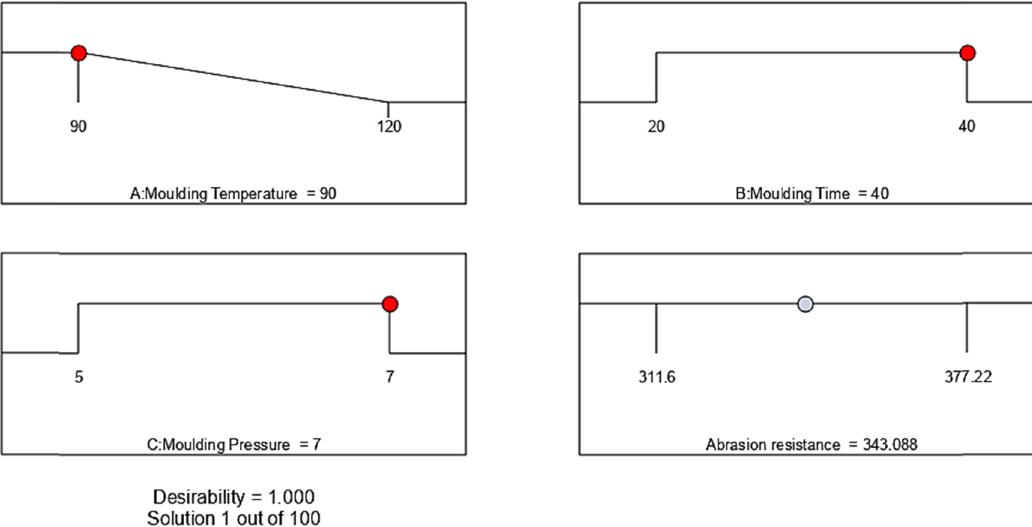
Figure 26: Ramp function graph for abrasion